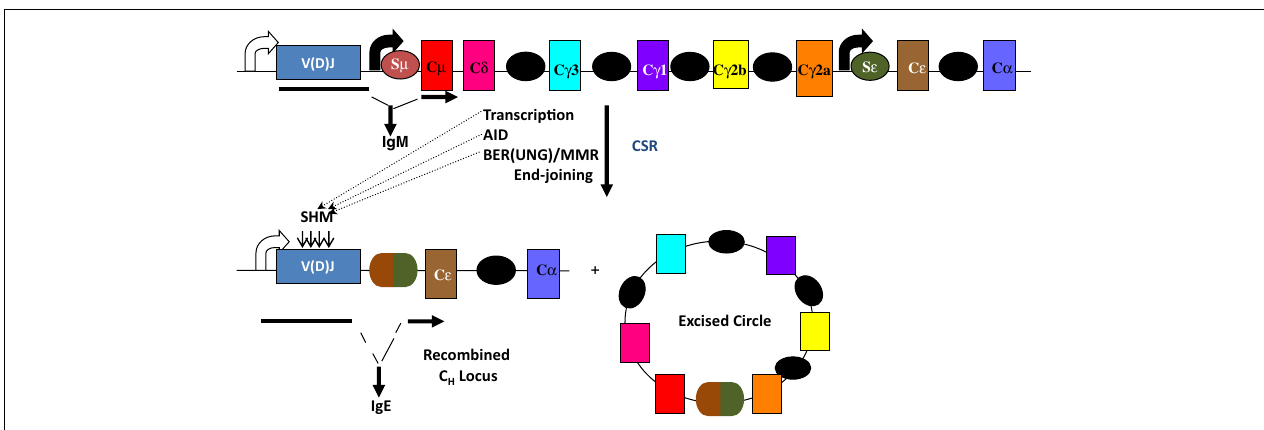
FIGURE 1 | Overview of CSR . CSR is a deletional-recombination reaction between repetitive switch (S) regions (ovals) that precede each set of constant region (C H ) exons. Cytokine-induced transcription through S regions drives CSR to specific C H exons. CSR requires AID and components of the base-excision repair (BER) and mismatch repair (MMR) pathways. Somatic hypermutation (SHM) introduces point mutations at a very high rate into variable region exons,V(D)J.